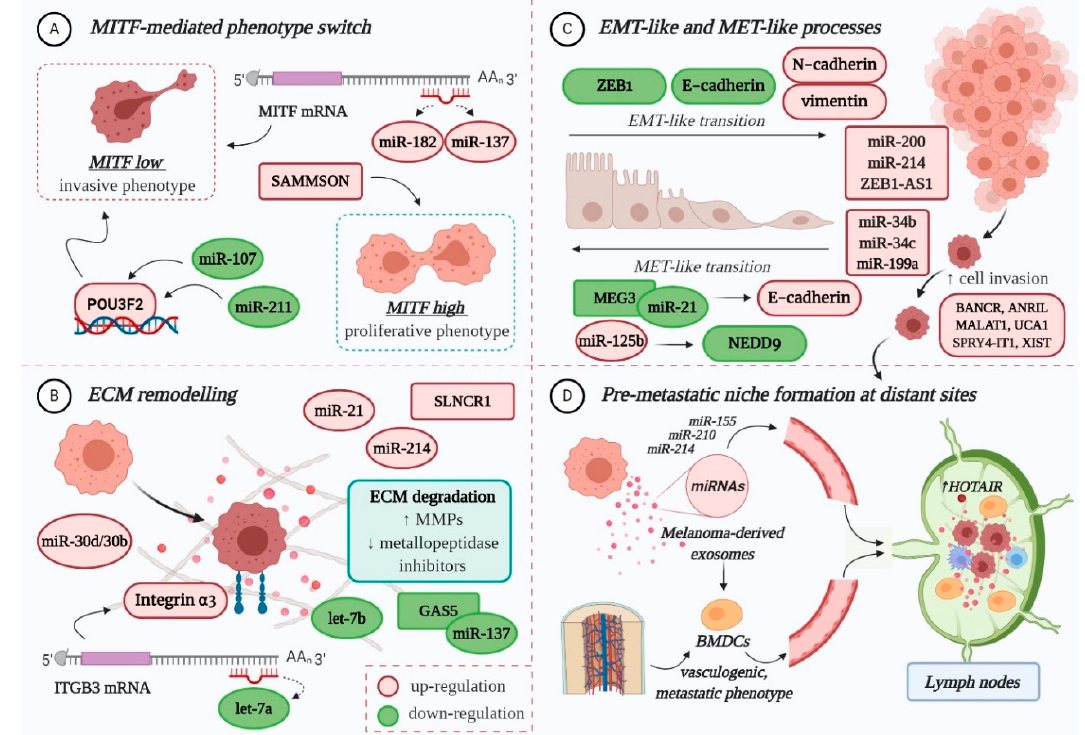
Figure 1. The role of non-coding RNAs in melanoma invasion and metastasis: ( A ) Both miRNAs and lncRNAs modulate the expression of MITF-M, directly or indirectly, therefore influencing the switch towards an invasive or proliferative phenotype; ( B ) The deregulated expression of ncRNAs facilitates ECM remodelling, by targeting integrins, increasing matrix metalloproteinases (MMPs) and diminishing the metallopeptidase inhibitors (TIMPs), therefore promoting ECM degradation and decreasing tumour cell-matrix adhesion; ( C ) Multiple miRNAs and lncRNAs favour the EMT- like process of melanoma cells, which enhances their migratory capacity, mainly by affecting the expression of specific adhesion molecules. Some ncRNAs also promote the MET- like process of malignant melanocytes, which leads to enhanced proliferation and colony formation, thus favouring metastasis; ( D ) The formation of a pre-metastatic niche at distant sites is mainly influenced by melanoma-derived exosomes, enriched in miRNA cargo (e.g., miR-155, miR-210, miR-214). In sentinel lymph nodes, they instigate microenvironmental changes that facilitate the recruitment, trapping and growth of circulating tumour cells. They also prime bone-marrow-derived cells (BMDCs), which achieve a vasculogenic, metastatic phenotype, and facilitate their recruitment to distant sites, where BMDCs will contribute to the formation of a pre-metastatic niche. LncRNA HOTAIR is enriched in lymph node metastases compared to primary tumours, which may suggest a role in the pre-metastatic niche formation. POU3F2: POU-domain class 3 transcription factor 2; NEDD9: Neural precursor cell expressed developmentally down-regulated protein 9; ZEB1: zinc finger E-box-binding homeobox 1. Colour code: red for upregulation and green for downregulation. Figure created with BioRender.com. True EMT in melanoma is not possible as melanocytes are not epithelial cells, however some miRNAs are implicated in an EMT-like process that promotes the invasion and metastasis of tumour cells. One of them is the cluster miR-224 / miR-452, which silences a metastatic suppressor that normally inhibits E2F1, and which has been shown to facilitate the cytoskeletal rearrangement of less aggressive cells, resulting in increased migratory and invasive propensity [55]. Also considered of particular relevance, the miR-200 family (miR-200a, miR-200b, miR-200c, and miR-141) drives the EMT-like process by upregulating the expression of Bmi-1 oncogene, which in turn promotes the activation of PI3K / AKT and MAPK cascades. This negatively influences the expression of ZEB1 (zinc finger E-box-binding homeobox 1) and E-Cadherin, at the same time stimulating N-Cadherin and